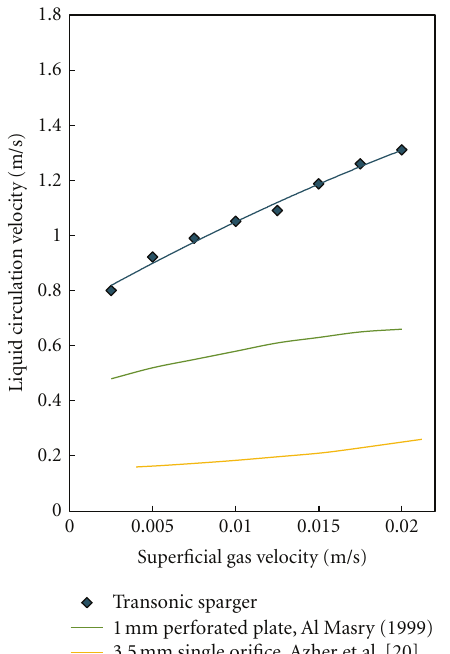
Figure 16: E ff ect of superficial gas velocity and sparger design on the liquid circulation velocity in ALR ( C S = 0ppm, Δ P S = 280 kPa).